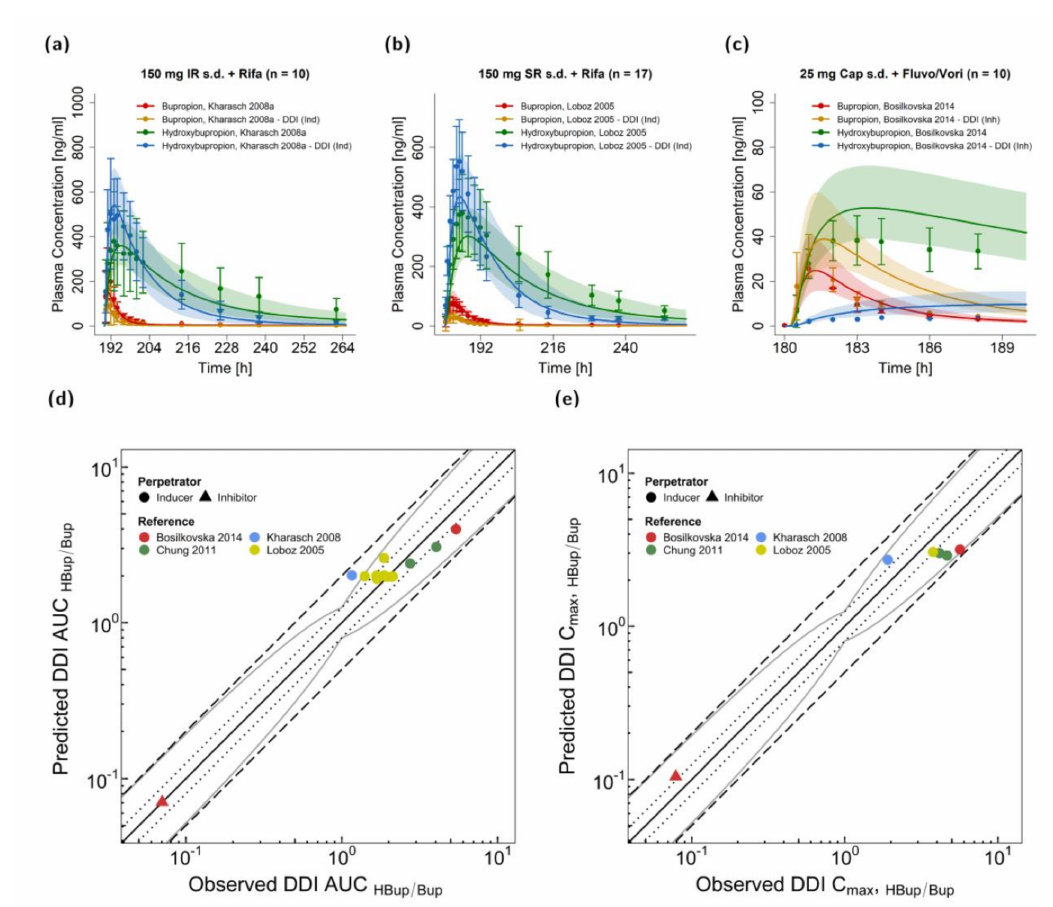
Figure 5. Victim drug plasma concentrations and DDI HBup/Bup ratios for AUC and C max of the modeled bupropion DDIs. Predicted compared to observed plasma concentration-time profiles of bupropion and hydroxybupropion are shown for interactions with rifampicin ( a , b ) as well as fluvoxamine and voriconazole ( c ). The profiles during administration of CYP2B6 perpetrator drugs are shown in orange and blue for bupropion and hydroxybupropion, respectively, and the corresponding profiles without DDI are shown in red and green for bupropion and hydroxybupropion, respectively. The solid line illustrates the geometric mean of the population predictions ( n = 500) and the shaded area the geometric standard deviation. Predicted compared to observed effect ratio plots for the hydroxybupropion–bupropion ratios of AUC ( d ) and C max ( e ) show data of four CYP2B6 inducer and one CYP2B6 inhibitor studies. Different shapes indicate the perpetrators and different colors the respective studies [19,22,35,44]. The straight solid line marks the line of identity; the curved solid lines show the prediction acceptance limits proposed by Guest et al. including 1.25-fold variability [85]. Dotted lines indicate 1.25-fold and dashed lines indicate 2-fold deviation. Details on the study protocols and the values of all DDI ratios are provided in the Supplementary Materials. AUC: area under the plasma concentration-time curve, Cap: capsule (Geneva Capsule [22]), C max : maximum plasma concentration, DDI: drug-drug interaction, Fluvo/Vori: fluvoxamine and voriconazole, HBup/Bup: hydroxybupropion–bupropion ratio, Ind: inducer, Inh: inhibitor, IR: immediate release, Rifa: rifampicin, s.d.: single dose, SR: sustained